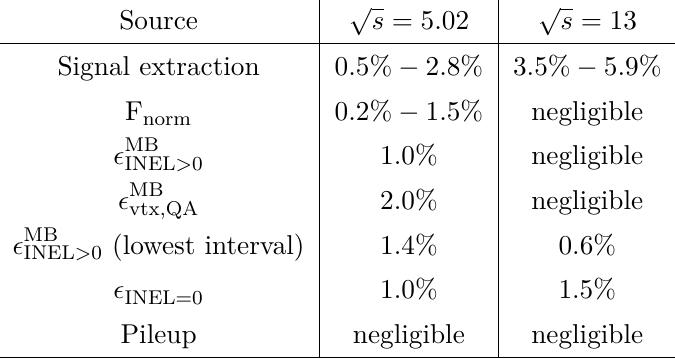
Table 4 . The summary of systematic uncertainties for relative J /ψ yield measurements.